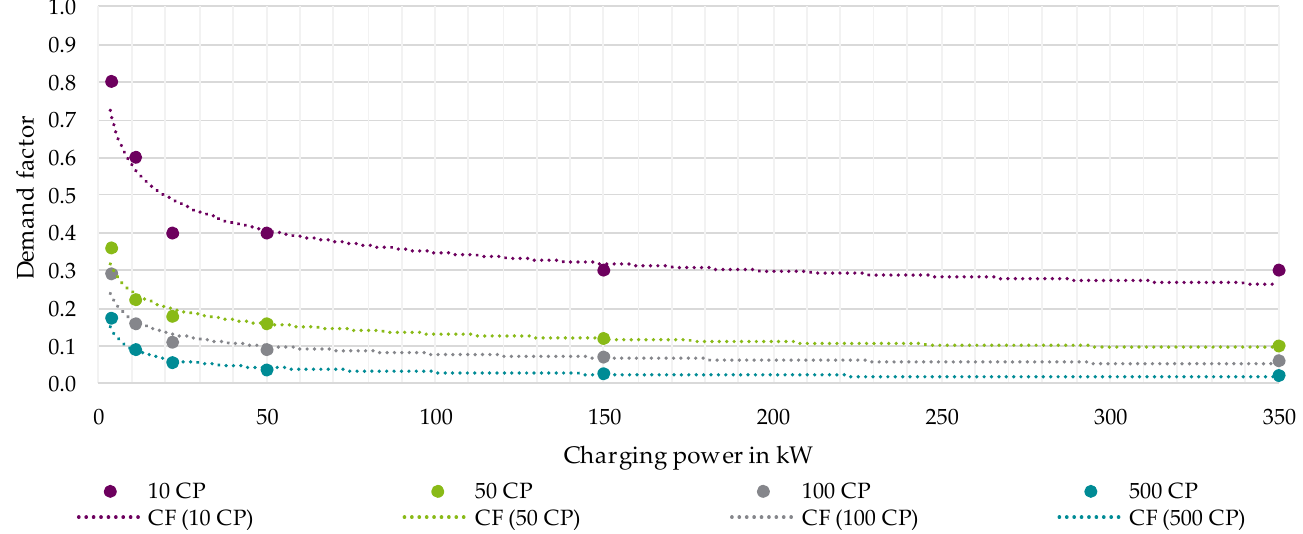
Figure 8. Process diagram for the simulation of charging profiles for different area types and charg- ing powers.